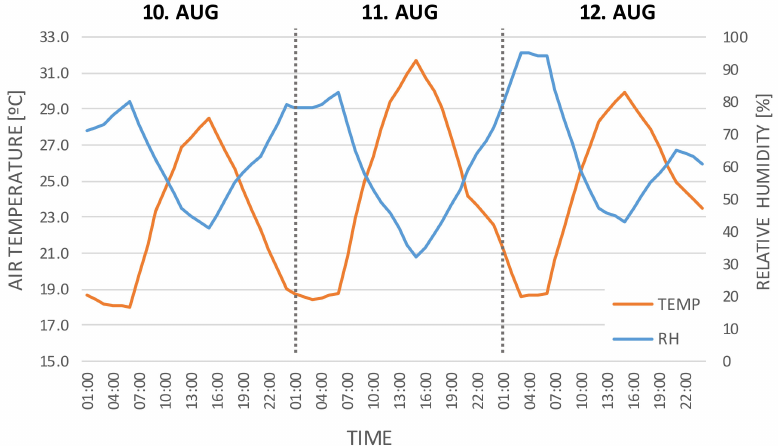
Figure 7. Hourly distribution of air temperature and relative humidity for the reference summer period (retrieved from the weather file portraying the typical reference year (TRY) representing the year 2018 (source: